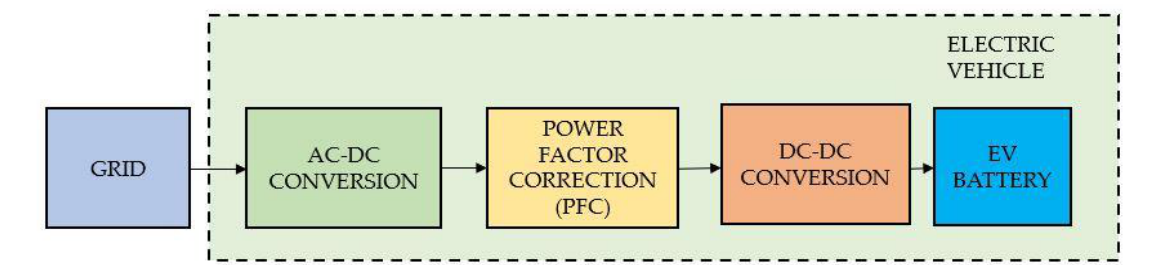
Figure 2. Block diagram schematic for on-board charging.